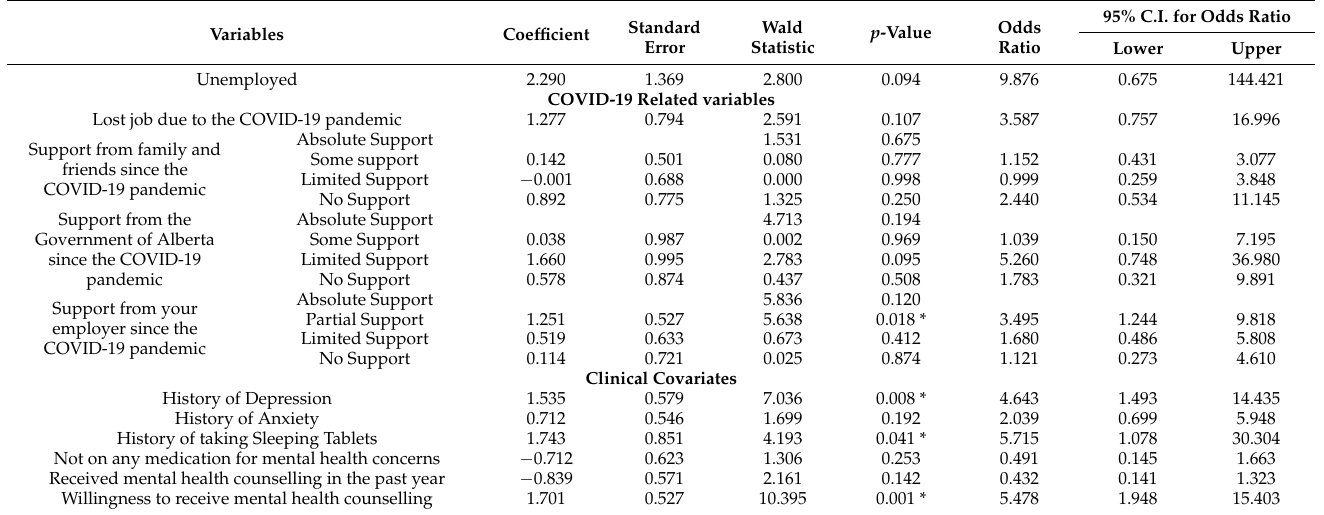
Table 3. Multivariate logistic regression model for respondents’ likelihood to present with Moderate to Severe